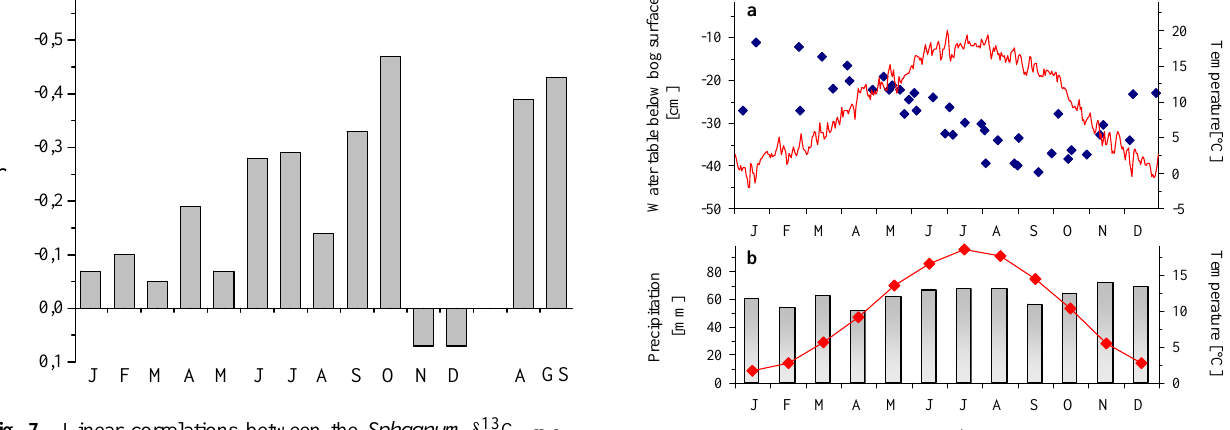
Fig. 7. Linear correlations between the Sphagnum δ 13 C cellulose values and average temperatures based on daily temperature data (1907–2004) from the meteorological station Trier ∼ 35km to the Southwest of D¨urres Maar ( n = 21). Bars 1–12 represent the cor- relations between the δ 13 C values and mean monthly tempera- tures (January–December); A represents the correlation between the Sphagnum δ 13 C cellulose values and the mean annual tempera- ture; GS represents the correlation δ 13 C values and the mean grow- ing season temperature (15.04.–15.10.). Average monthly-, grow- ing season-, and growing season temperature were calculated for each ∼ 4.5 yr time interval to maintain the same temporal resolution than the peat samples (for details see Sect. 5.3).